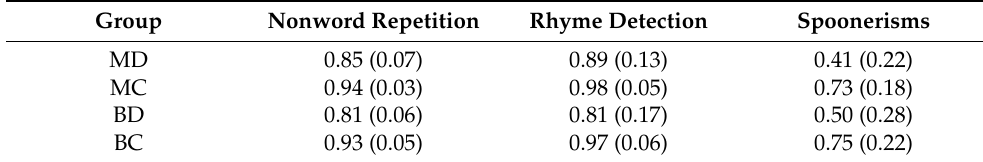
Table 4. Mean accuracy (SDs) of the four groups in the phonological tasks. Group Nonword Repetition Rhyme